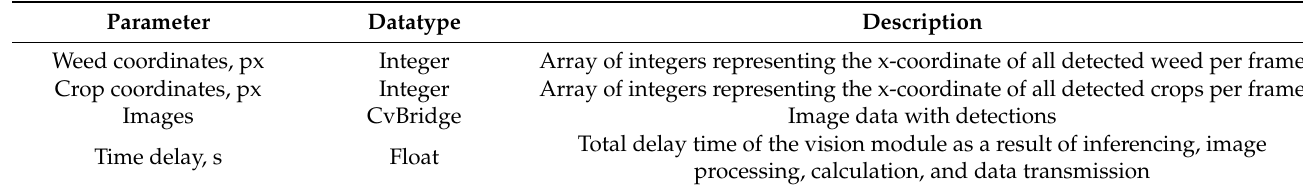
Figure 5. Software framework of the vision module. Table 4. Output parameters of the vision module with their